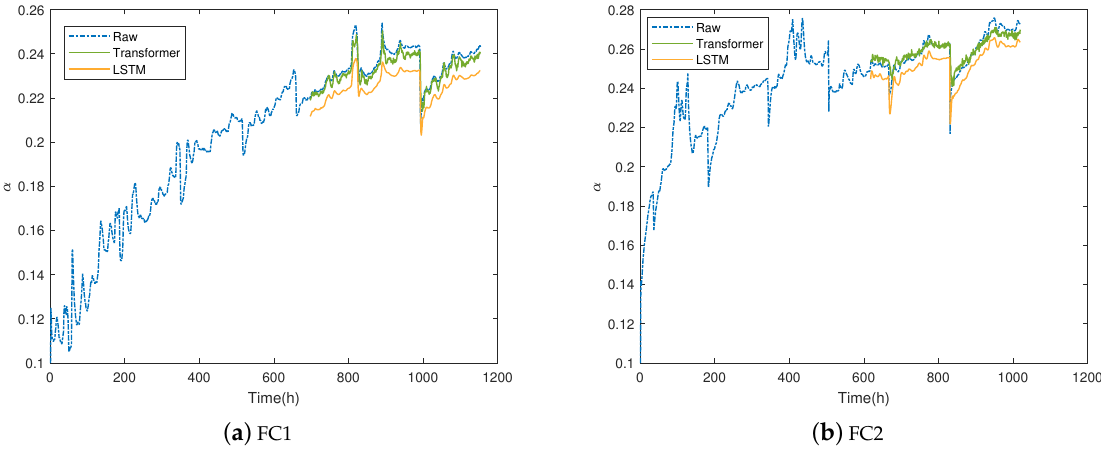
Figure 10. The result of PEMFC for degradation prediction with proposed method and